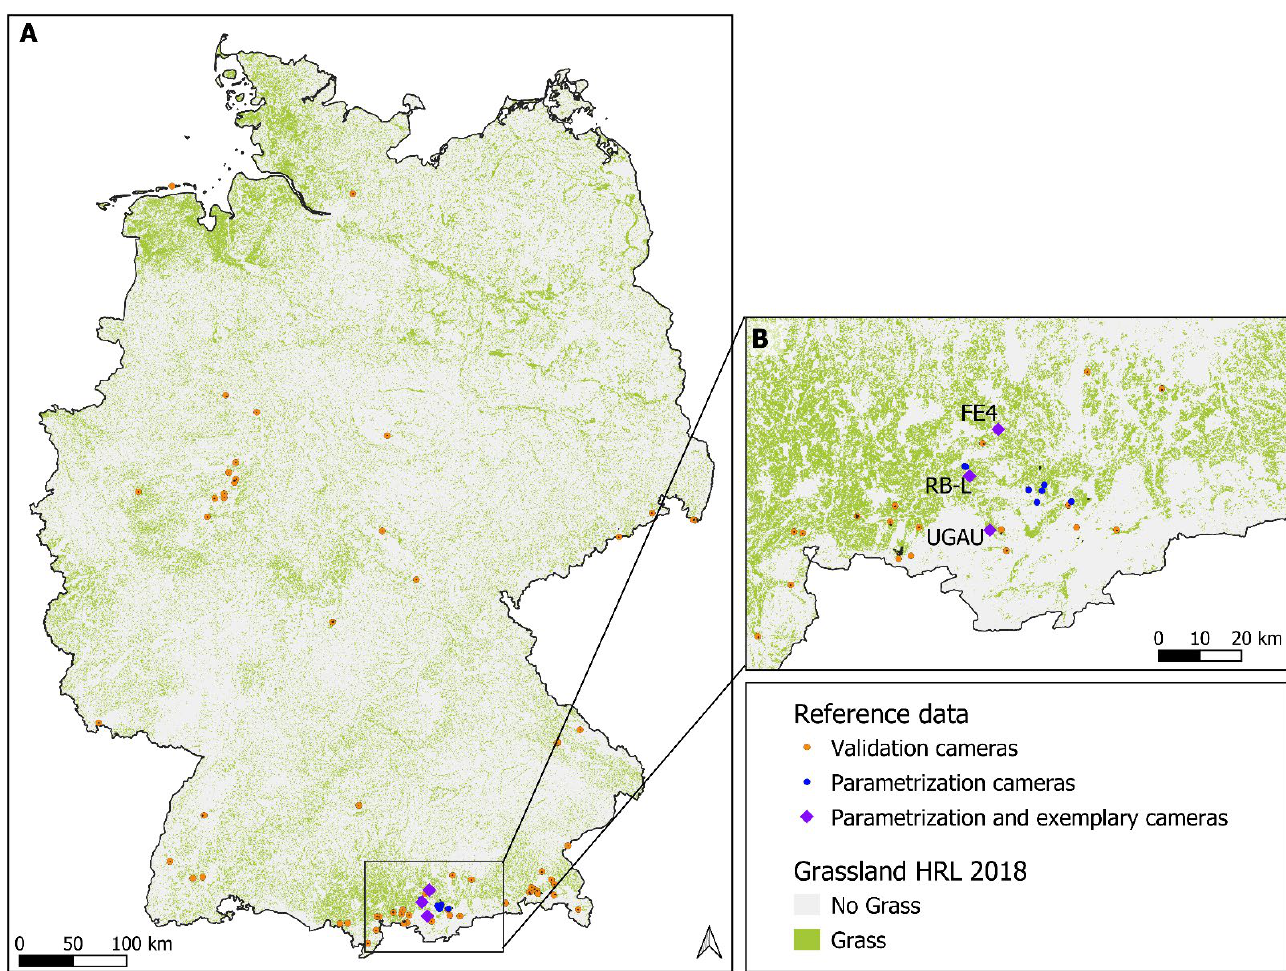
Figure 1. Distribution of grassland in Germany ( A ) and the focus region ( B ) according to the Copernicus grassland HRL for 2018 [36], and camera positions used to derive information on mowing dynamics to parameterize and validate the satellite-based products.